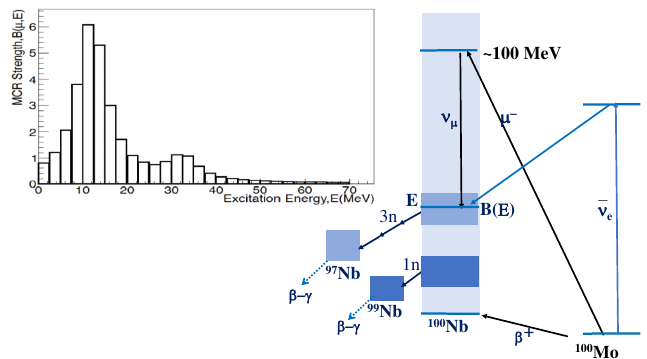
Figure 9. Schematic diagram of muon CER and the transition rate as a function of excitation energy.